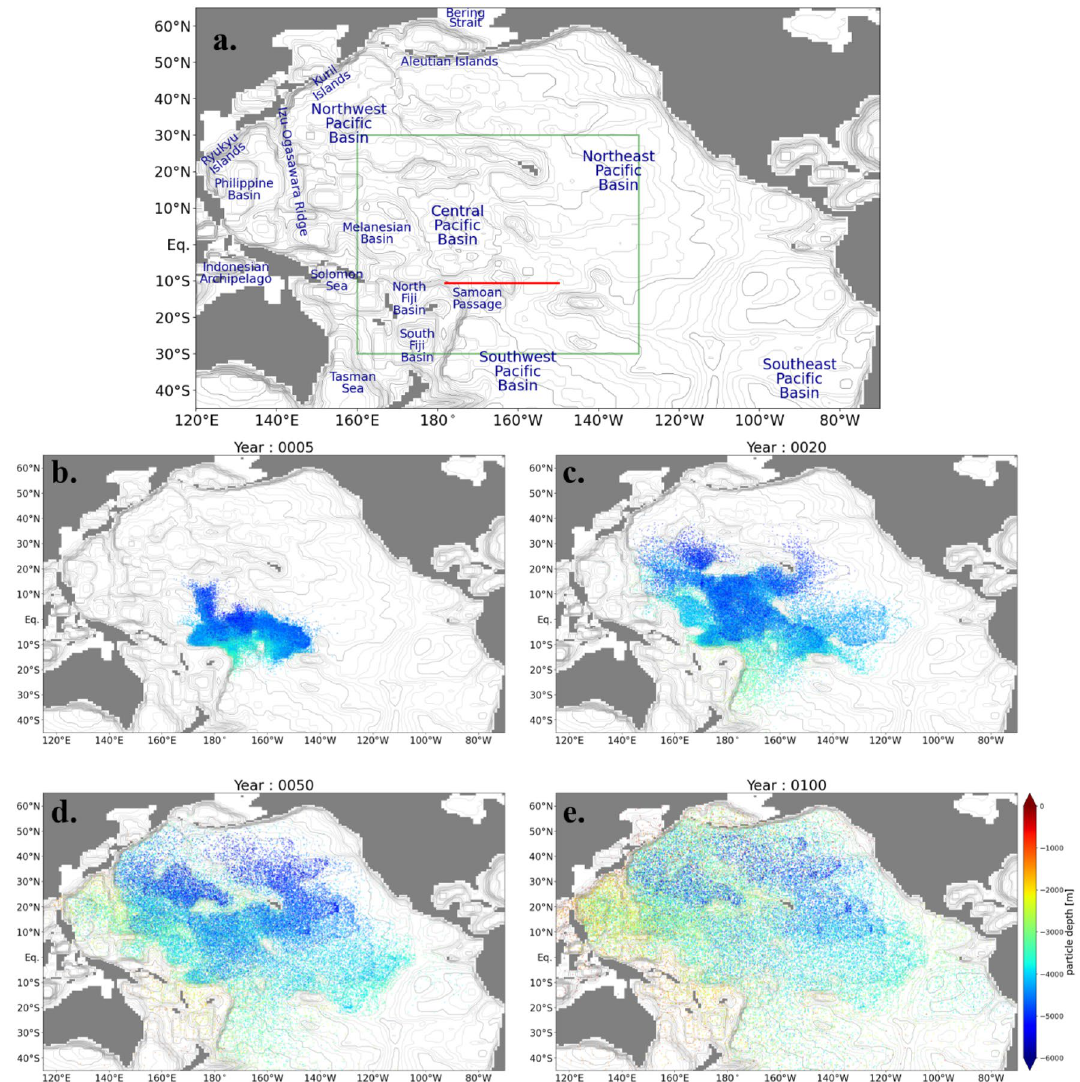
Figure 1. ( a ) Map of the Pacific Ocean. The red line indicates the section where the Lagrangian particles are released. The green box indicates the range of Fig. 7b. Positions of the Lagrangian particles ( b ) 5 years, ( c ) 20 years, ( d ) 50 years, and ( e ) 100 years after particle tracking started. The color indicates the depth of particles. For readability, one in every 47 particles is plotted. The gray contour indicates the seafloor depth in our model. The thick and thin contour intervals are 200 and 1000 m,